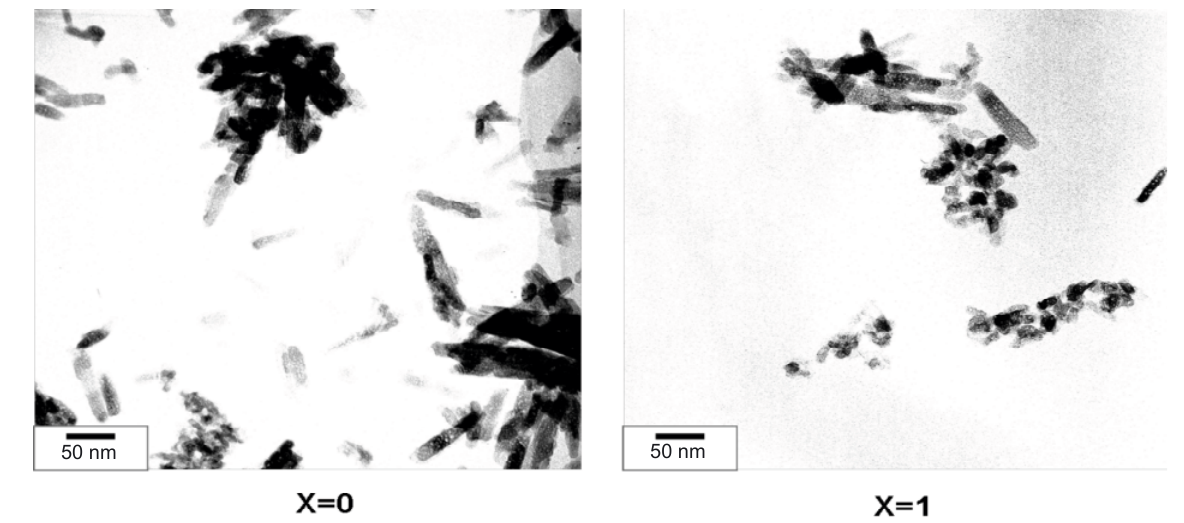
Figure 3. TEM image of CHA powders (x = 0, 1)